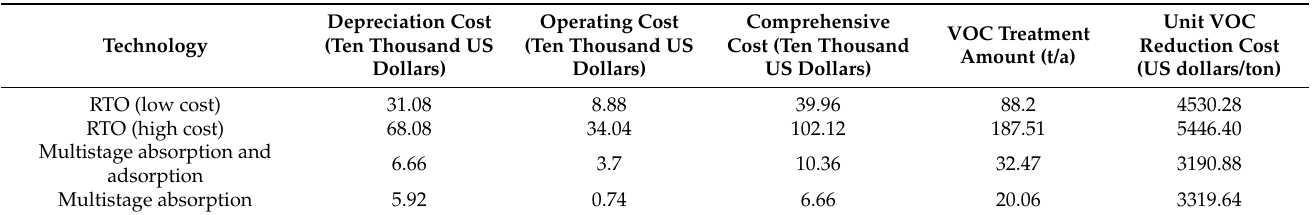
Table 7. Emission reduction benefits and economic evaluation of different treatment facilities in the pesticide industry.